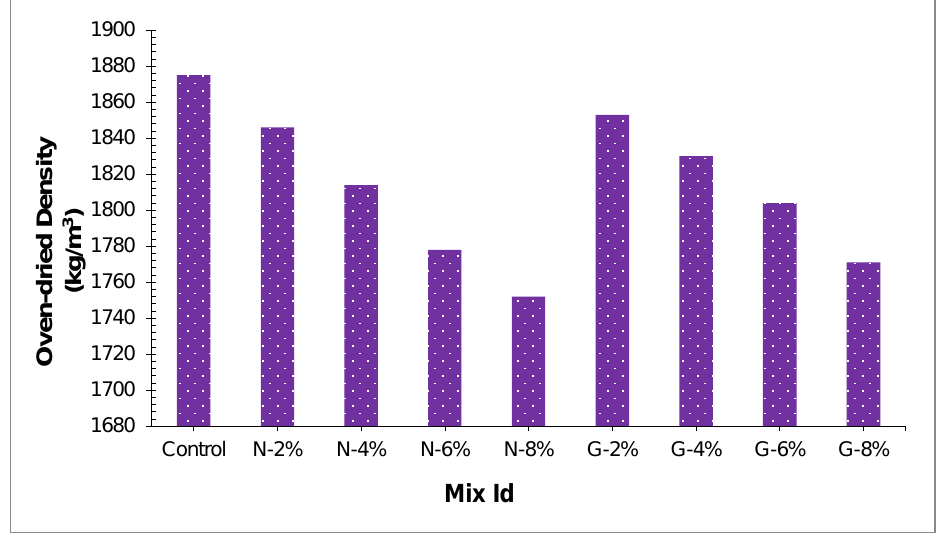
Figure 4. Oven-dried density of all concrete samples.